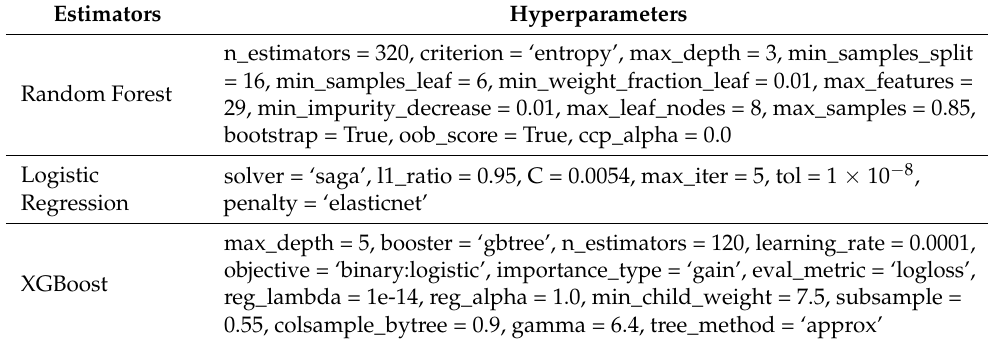
Table 3. Hyperparameters of estimators.